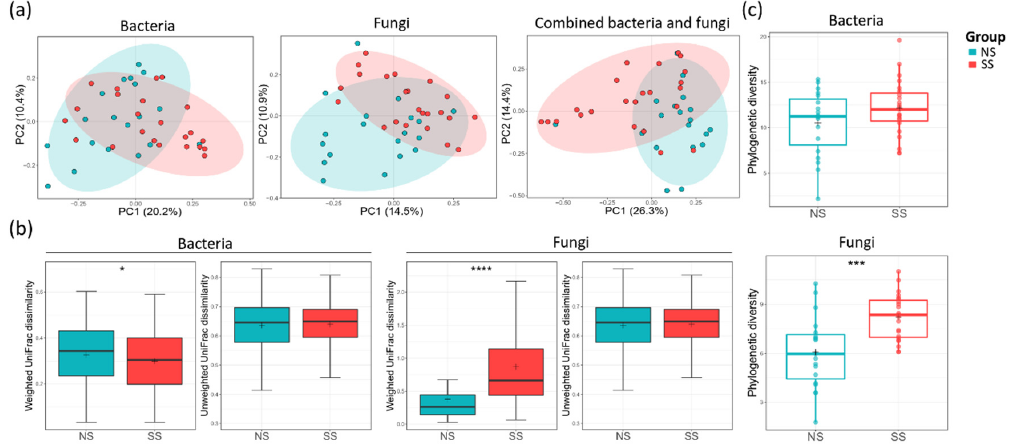
Figure 1. Bacterial and fungal communities of the two skin groups. ( a ) The bacterial (analysis of similarity (ANOSIM), p = 0.002) and fungal (ANOSIM, p = 0.006) principal coordinate analysis (PCoA) plots by unweighted UniFrac distance and combined bacterial / fungal PCoA by Bray–Curtis distance (ANOSIM, p = 0.001). ( b ) The UniFrac dissimilarity in the bacterial and fungal communities calculated within each skin group. ( c ) The alpha diversities of the bacterial and fungal communities by using Faith’s PD index. The statistical significance of the di ff erences between the skin groups is indicated by ns > 0.05, * p ≤ 0.05, *** p ≤ 0.001, and **** p ≤